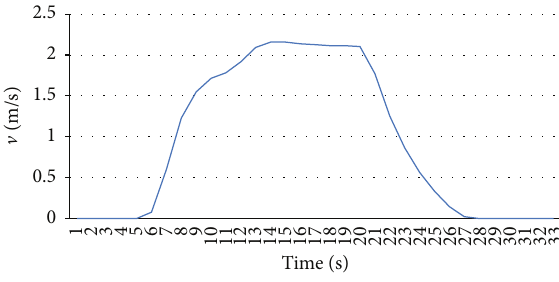
Figure 27: Underwater vehicle feedback speed